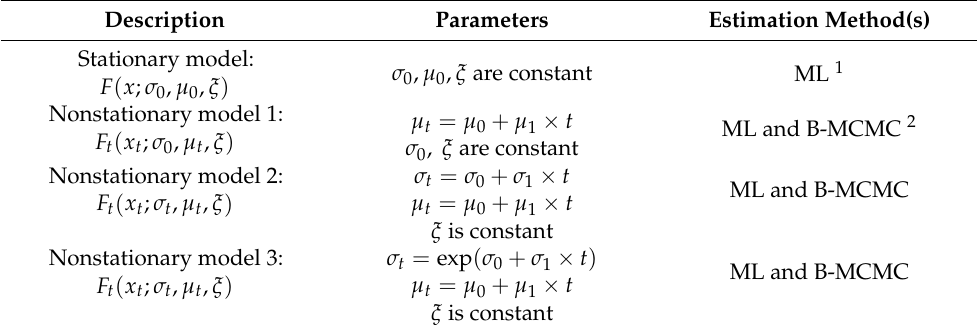
Table 1. Stationary and nonstationary GEV models and the estimation methods used in this study. Description Parameters Estimation